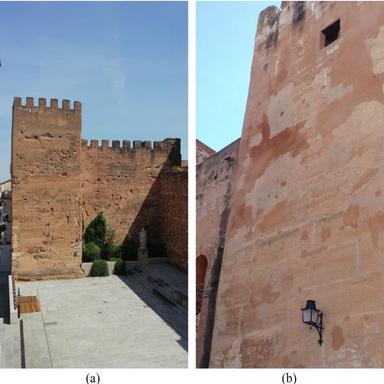
De la Yerba tower and RE overpass that connects the tower to the rampart (a) and Del Horno Tower (b).